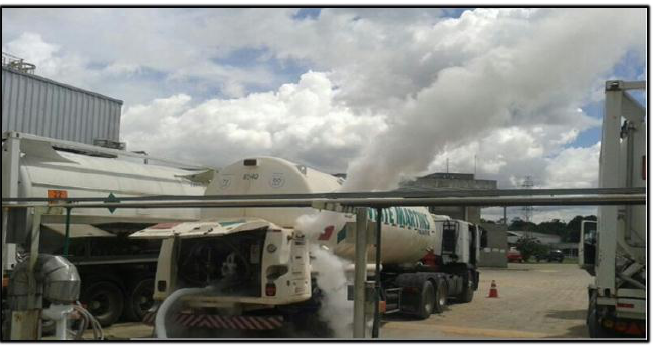
e N líquido (m³) -2º semestre de 2 2